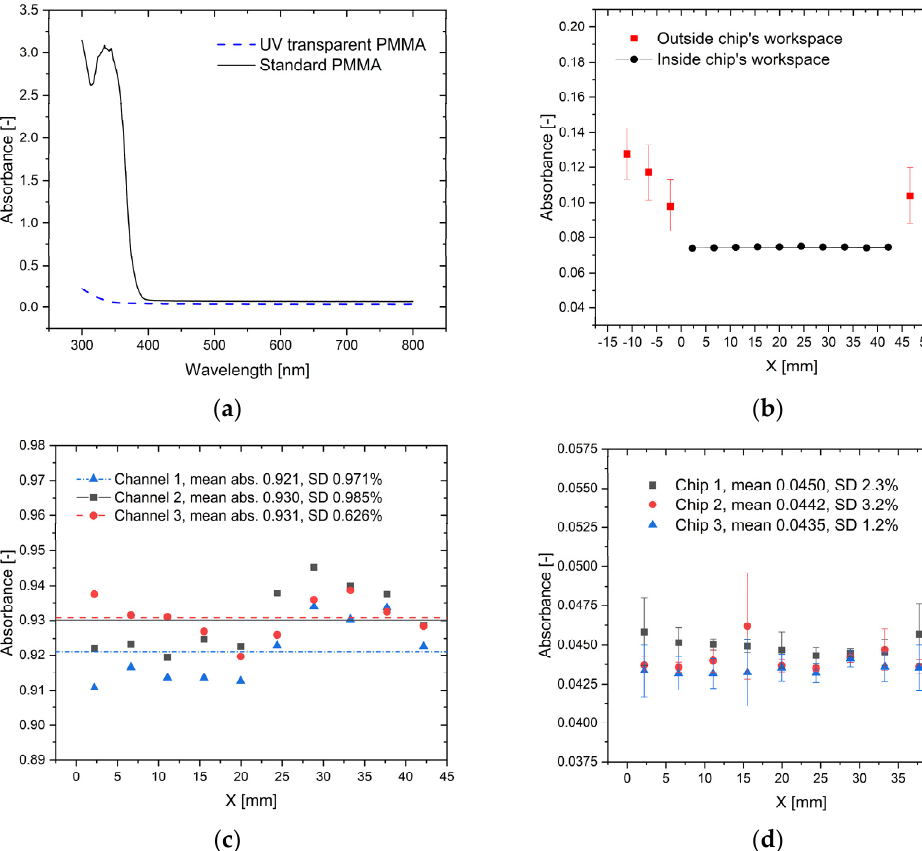
Figure 3. The light absorbance by the microdevice: ( a ) The spectrum 300–800 nm mean value for the empty CC; ( b ) The absorbance profile along of the empty CC at 668 nm, Plexiglas XT; ( c ) The absorbance profile along of CC filled with the indicator (MB 0.133%, CTAB 0.2%, 668 nm); ( d ) The absorbance profile along CC filed with 0.2% CTAB at 668 nm, Plexiglas XT.